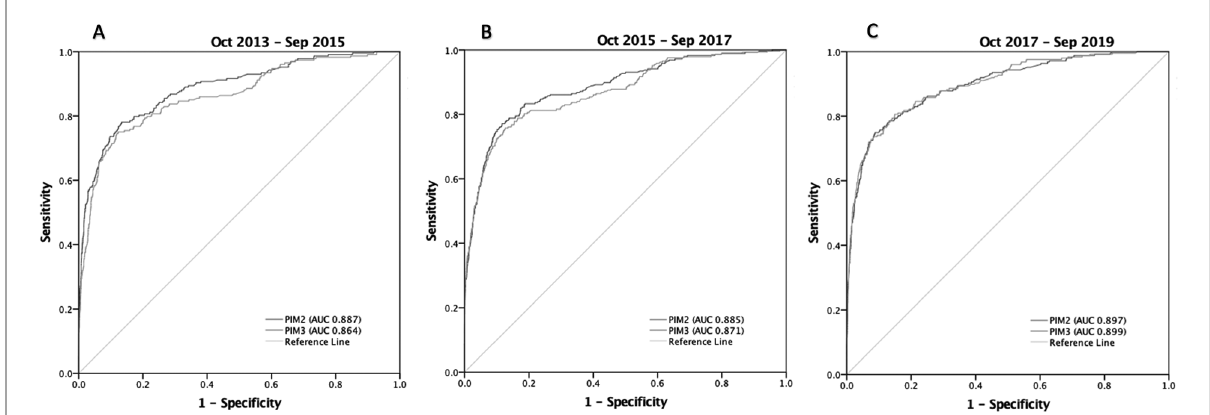
FIGURE 4 Receiver operating characteristic (ROC) curves for PIM3 and PIM2, and areas under the curve (AUROC) in the three periods from October 2013 to September 2019. ( A ) Period 1(Oct-2013 to Sep-2015): PIM2: 0.89 (95% CI 0.86-0.91); PIM3: 0.86 (95% CI 0.84-0.89) ( P =0.0018); ( B ) Period 2 (Oct- 2015 to Sep-2017): PIM2: 0.89 (95% CI 0.86-0.91); PIM3: 0.87 (95% CI 0.85-0.90) ( P =0.0136); ( C ) Period 3 (Oct-2017 to Sep-2019): PIM2: 0.90 (95% CI 0.88-0.92); PIM3: 0.90 (95% CI 0.88-0.92) ( P